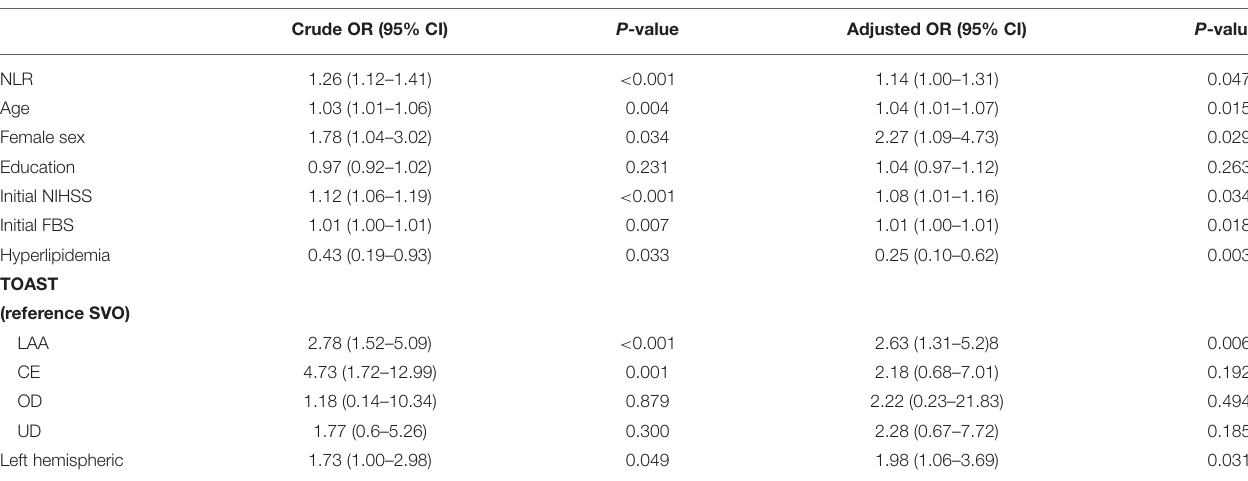
TABLE 3 | Multivariable analysis for possible predictors of